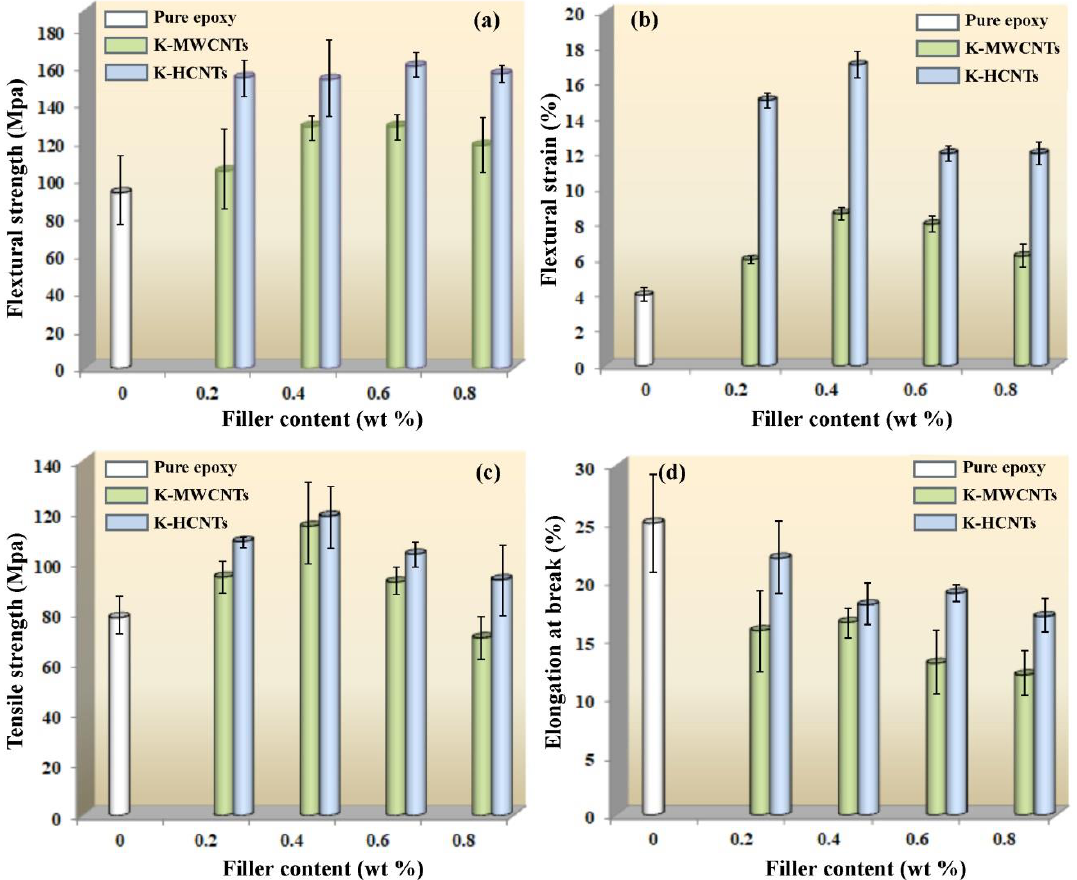
Figure 9. Comparison of the flexural and tensile properties of glycidoxypropyltrimethoxysilane (KH560) modified multi-walled carbon nanotube (K-MWCNT)/epoxy and K-HCNT/epoxy composites. Flexural strength ( a ), flexural strain ( b ), tensile strength ( c ), and elongation at break ( d ) of pure epoxy, K-MWCNT/epoxy and K-HCNT/epoxy composites as a function of the filler content.